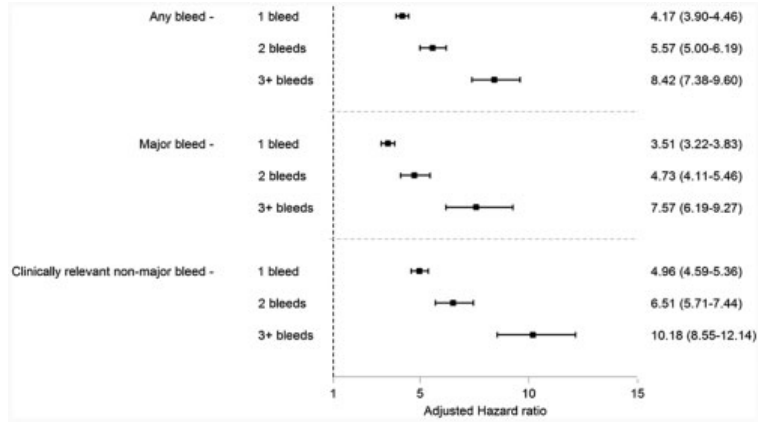
Fig. 3 Forest plot describing the hazard of primary and secondary bleed outcomes during VKA treatment in the period following the fi rst, second, and third bleeds compared with the hazard in the period before any bleeds have occurred. Hazard ratios adjusted for all characteristics are listed in ► Table 1 . VKA, vitamin K antagonist.